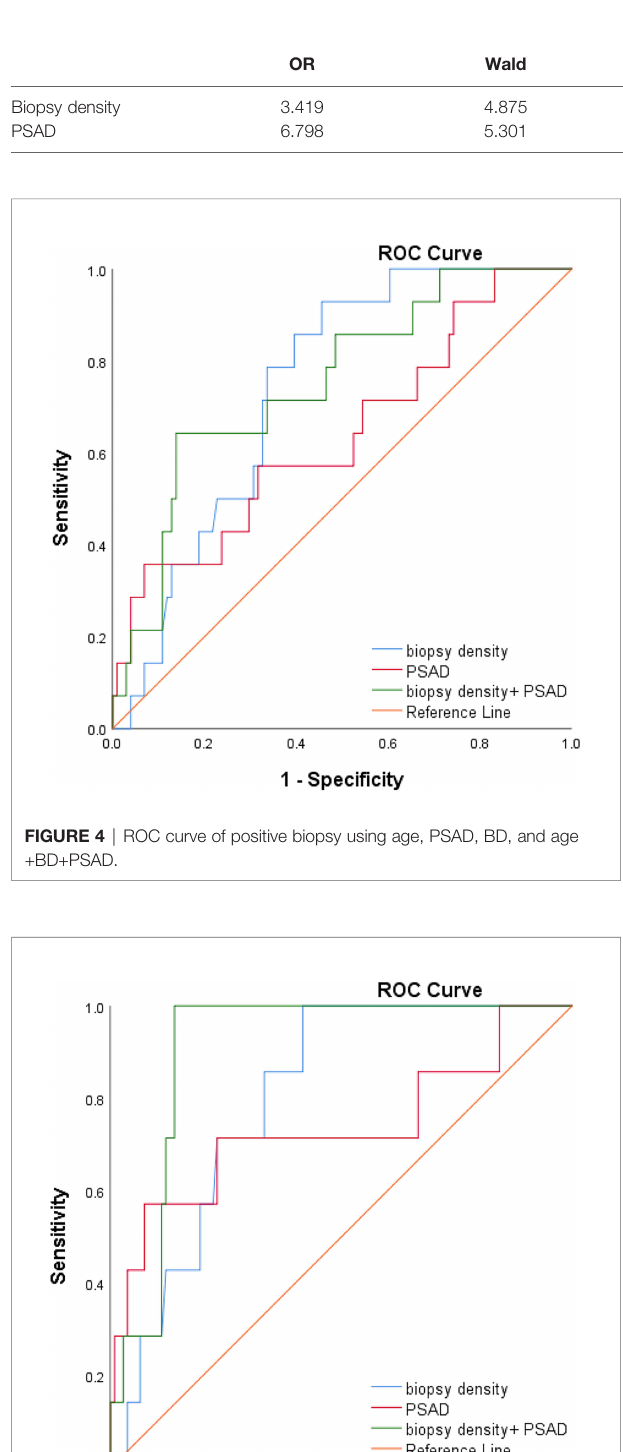
TABLE 4 | Results of binary logistic regression analysis (csPCa group vs. non-csPCa group).